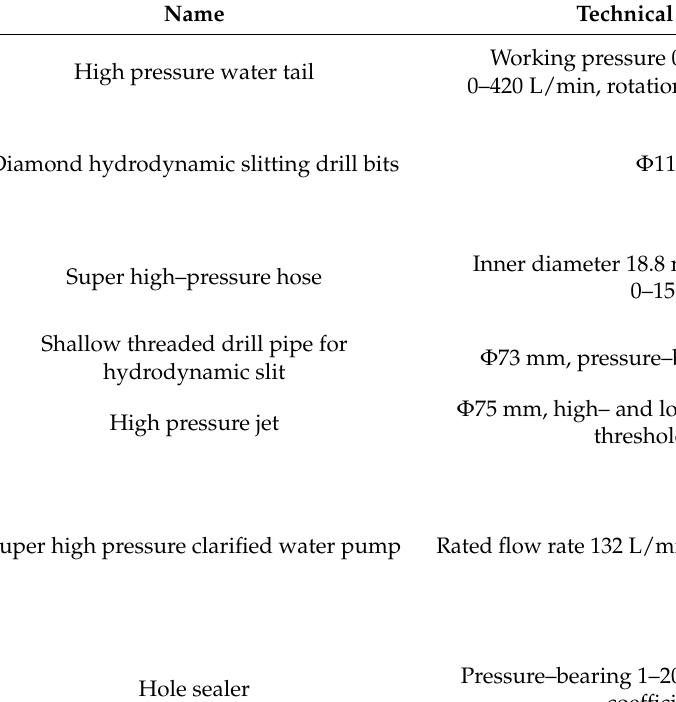
Table 4. Technical parameters of the main equipment for hydraulic roof cutting and pressure relief.